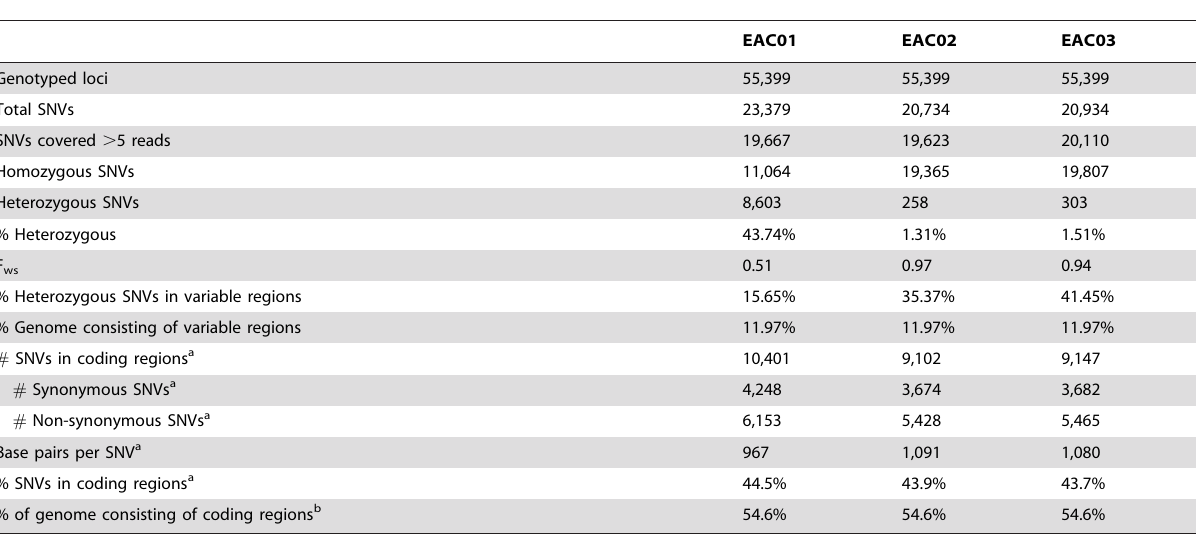
Table 2. SNV genotyping set: East African sample SNV statistics.